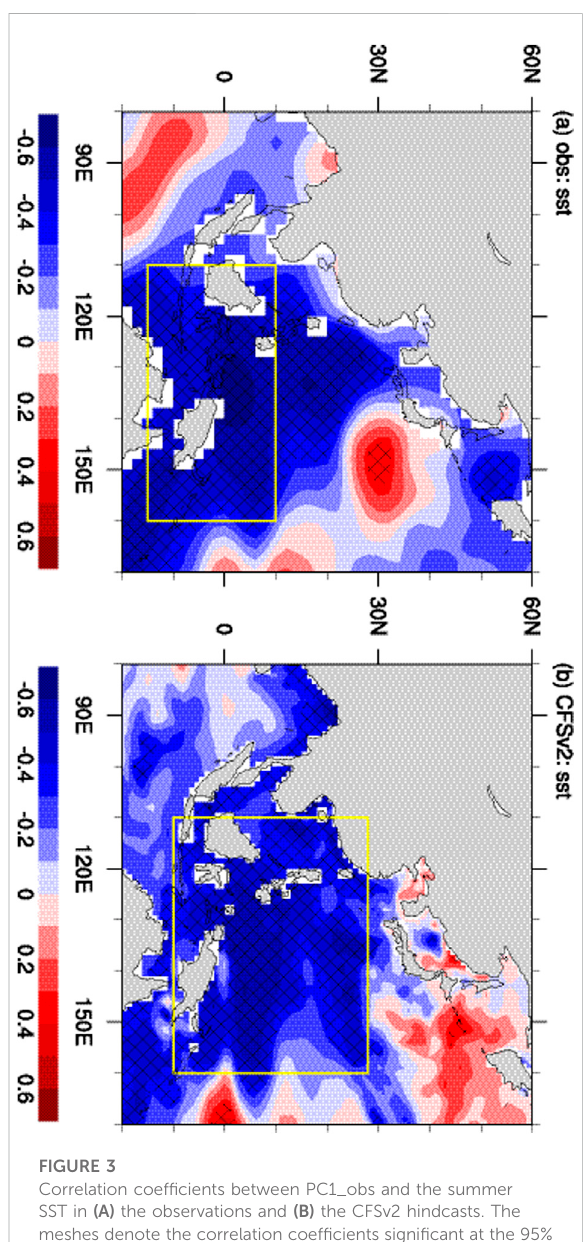
Anomalies of the summer (A) 500 hPa vertical velocity (shading; units: 10 – 3 Pa s − 1 ) and 850 hPa horizontal wind (vector; units: m s − 1 ), (B) surface net downward shortwave radiation (units: W m − 2 ) and (C) FEHEs in the observations regressed on the time series of the sign-reversed MCSST. The dots denote the anomalies signi fi cant at the 90% con fi dence level based on Student ’ s t -test. Only the anomalies of the 850 hPa wind exceeding 0.1 m s − 1 are